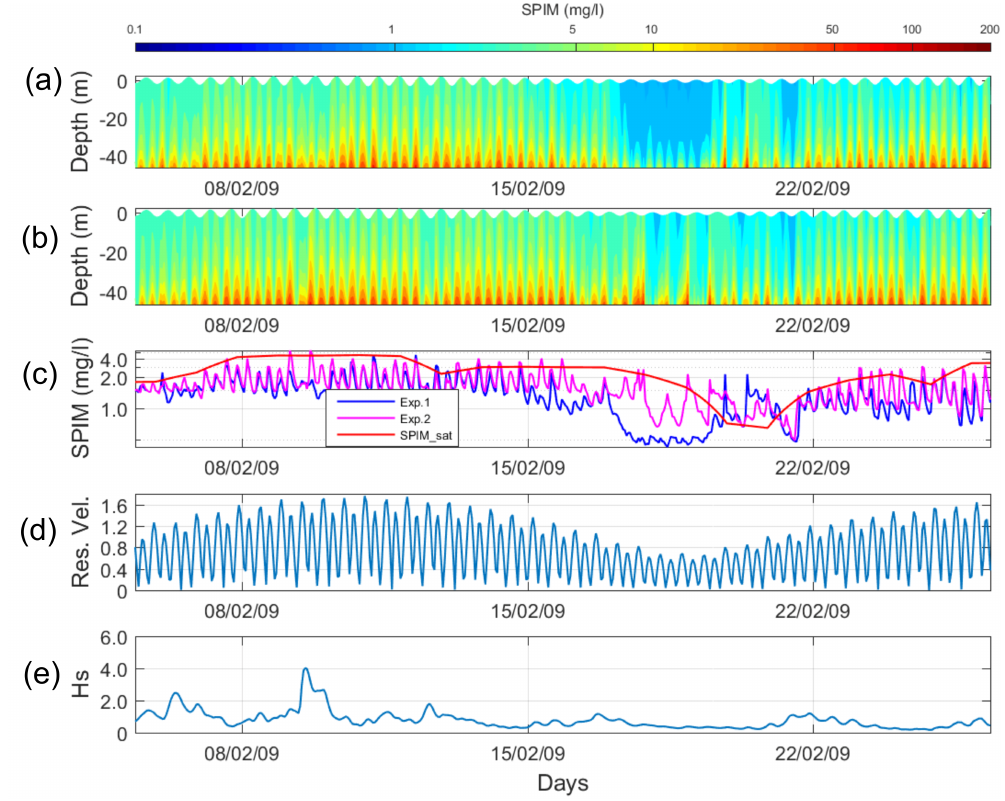
Figure 10. Section of 21 days of suspended particulate inorganic matter (SPIM) from out-of-learning phase for Exp. 1 in ( a ) and Exp. 2 in ( b ), surface SPIM (Exp. 1, Exp. 2 and SPIM _ sat ) in ( c ), resultant barotropic velocity in ( d ), and significant wave height ( Hs ) in ( e ) at station